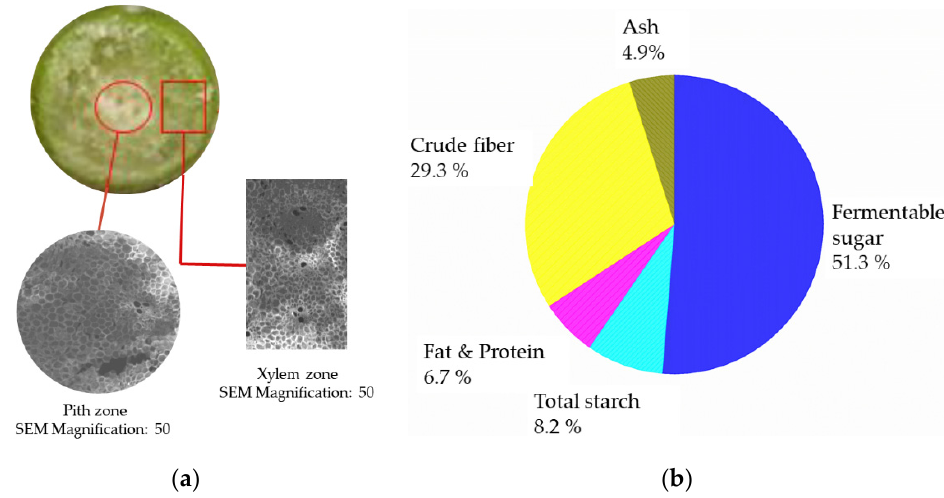
Figure 1. Structure and composition of sweet sorghum stalks. ( a ) Cross section of stalk and SEM image of pith and xylem zones. ( b ) Composition of sweet sorghum stalks. (The results are expressed as percentage of dry weight).